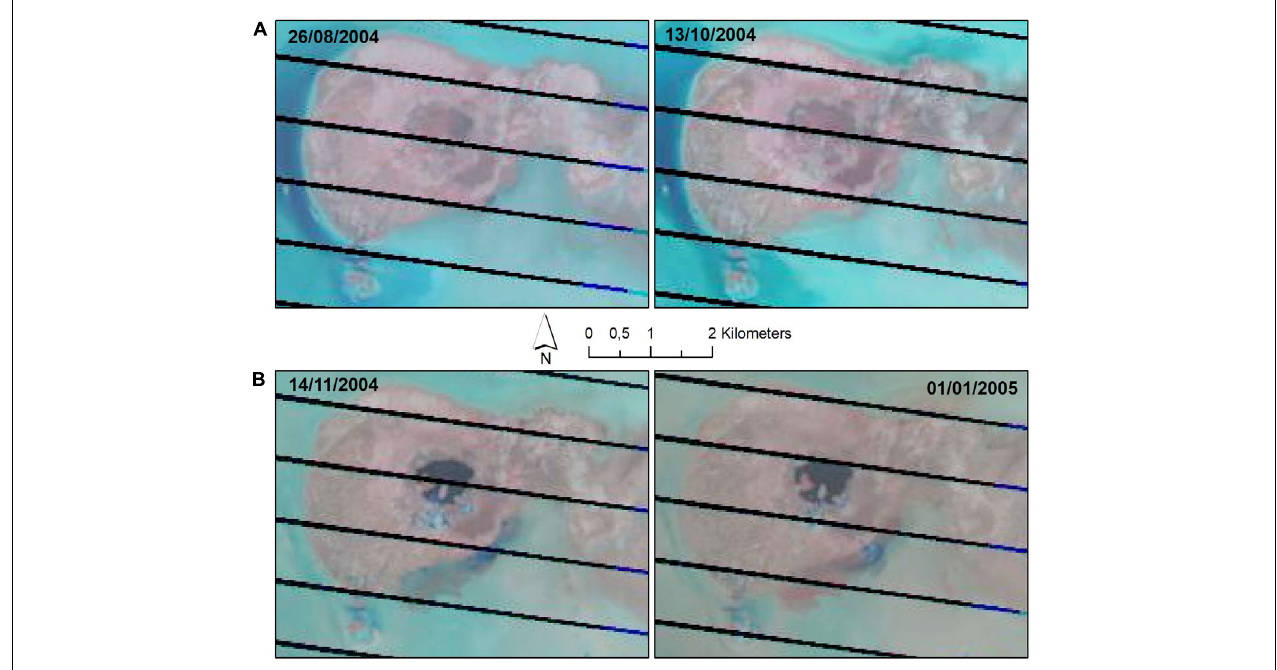
FIGURE 9 | Satellite images showing the 2004 dyke-intrusion event. Landsat 7 (NASA) satellite images over the Dallol dome before (A) and after (B) the dyke-intrusion event of October 22th – November 4th